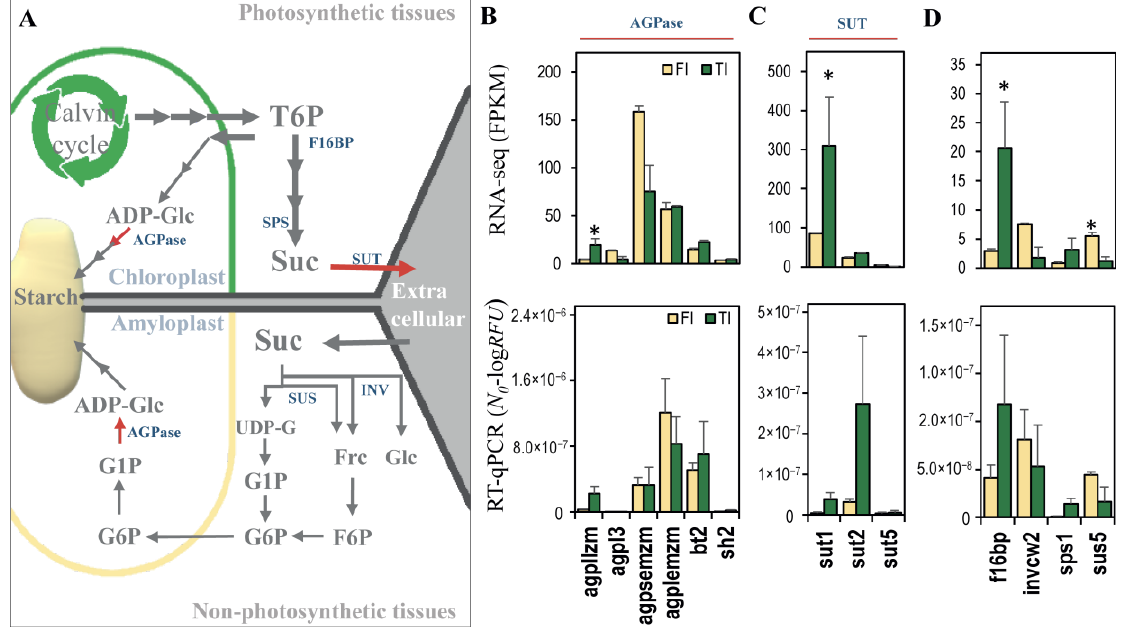
Figure 5. Transcript levels of genes for sucrose–starch metabolism enzymes. ( A ) Summary of sucrose– starch pathway in photosynthetic and non-photosynthetic cells. ( B – D ) Transcript quantification by RNA-seq (upper row) and validation by RT-qPCR (lower row). ( B ) ADP-Glucose pyrophosphorilase (AGPase) family, Agpllzm, Agpl3, Agpsemzm, Agplemzm, Bt2, Sh2. ( C ) Sucrose transporter (SUT) family, Sut1, Sut2, Sut5. ( D ) Fructose 1,6 bi-phosphatase (F16bp), Invertase (Invcw2), Sucrose Phosphate Synthase (Sps1), and Sucrose Synthase 5 (Sus5). * Significantly differential expression FDR <